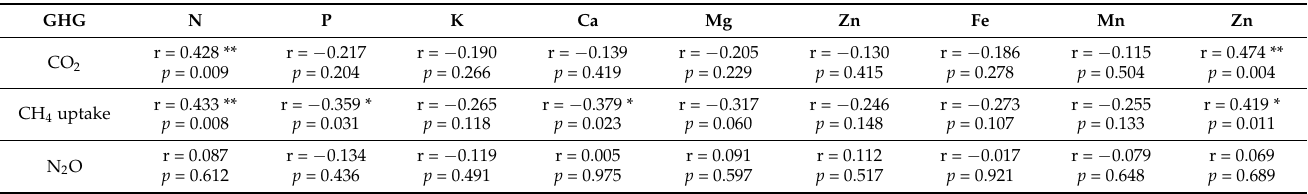
thinning, where r: correlation coefficient, p value: significance